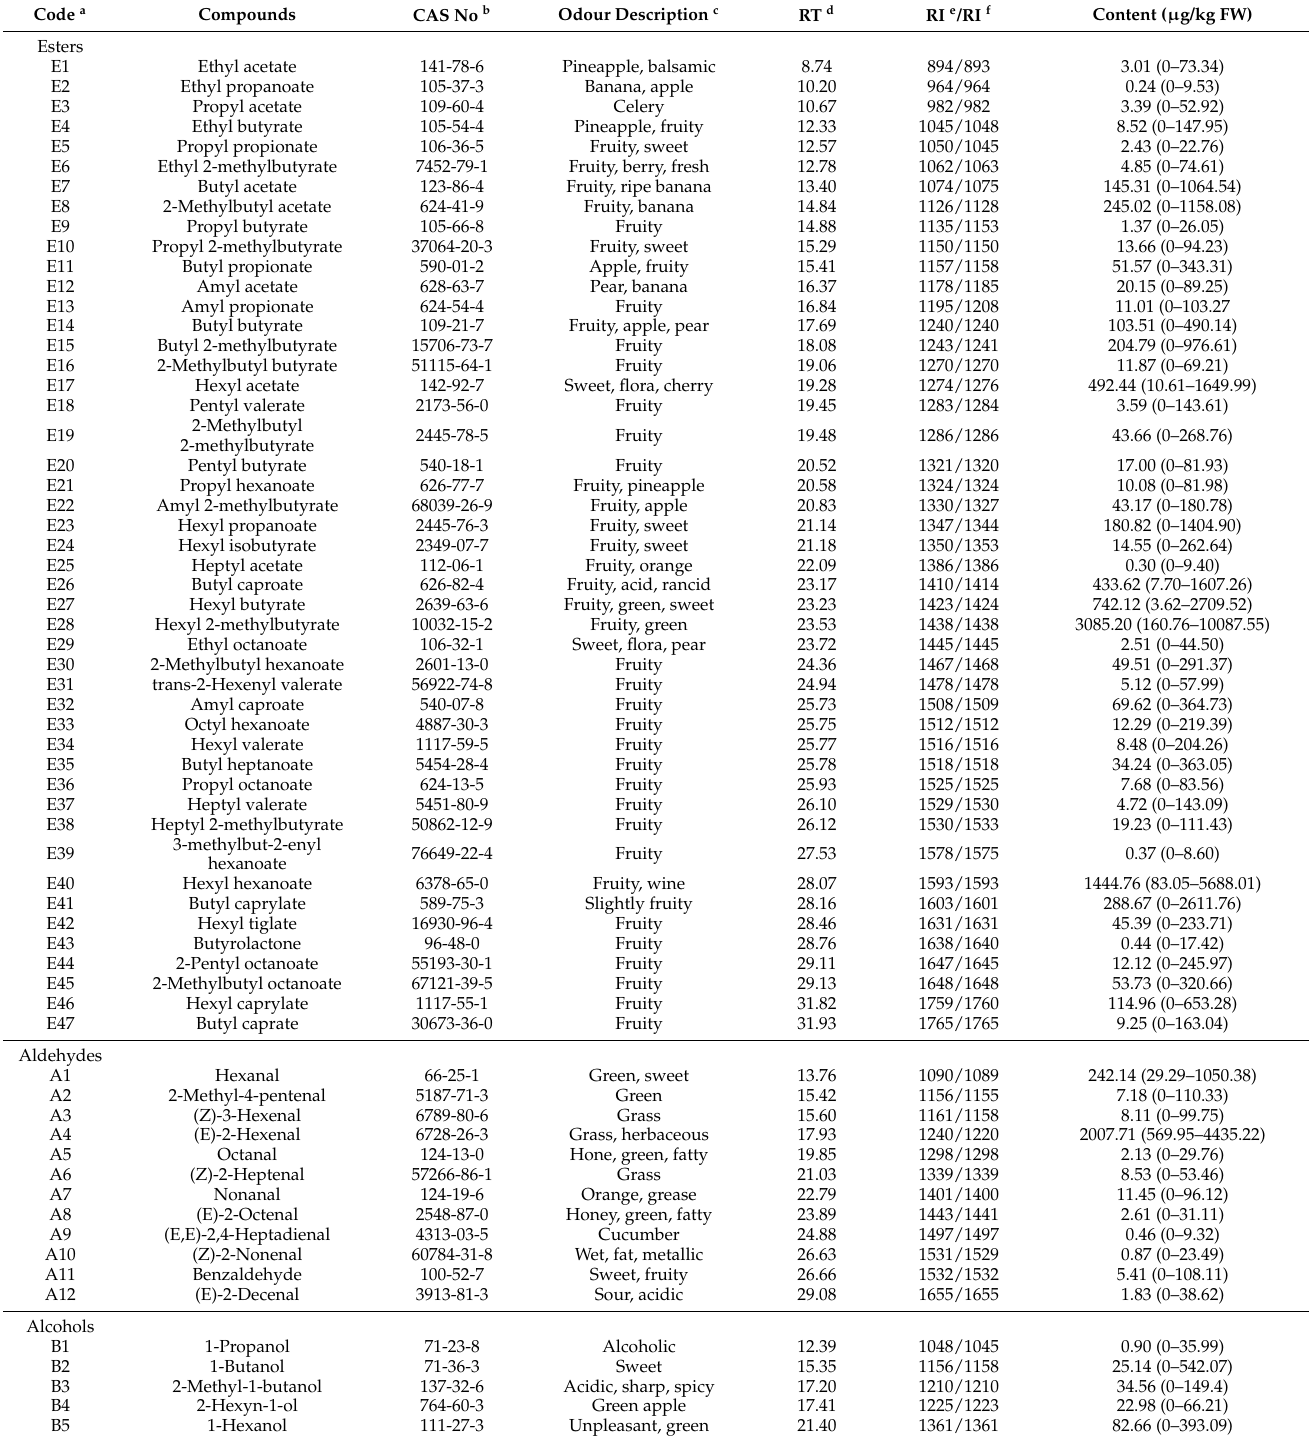
Table 2. Average contents of volatile compounds ( n = 3, equivalent of 3-nonanone) and their distribution ranges (in parenthesis) in the peels of 40 apple